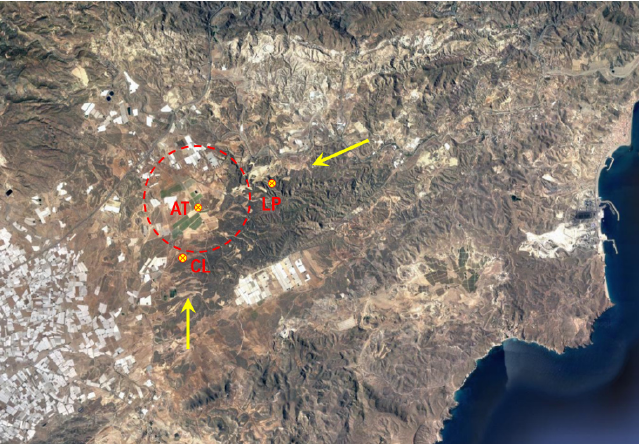
Figure 6. Locations of soil types and main wind directions. Table 2. Sediment transport rate (Q r ) balance.